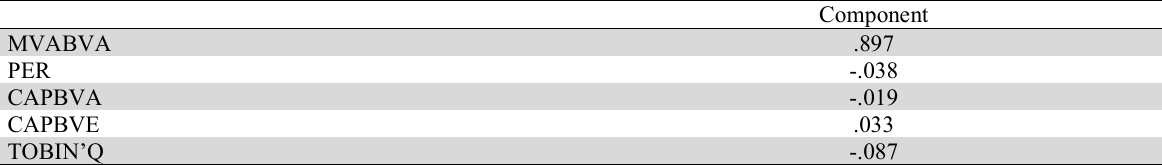
Results of Matrix Component Factor Analysis